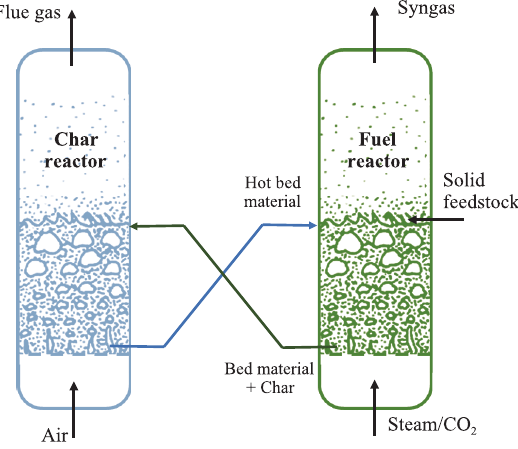
Fig. 3 Concept of DFB fuel